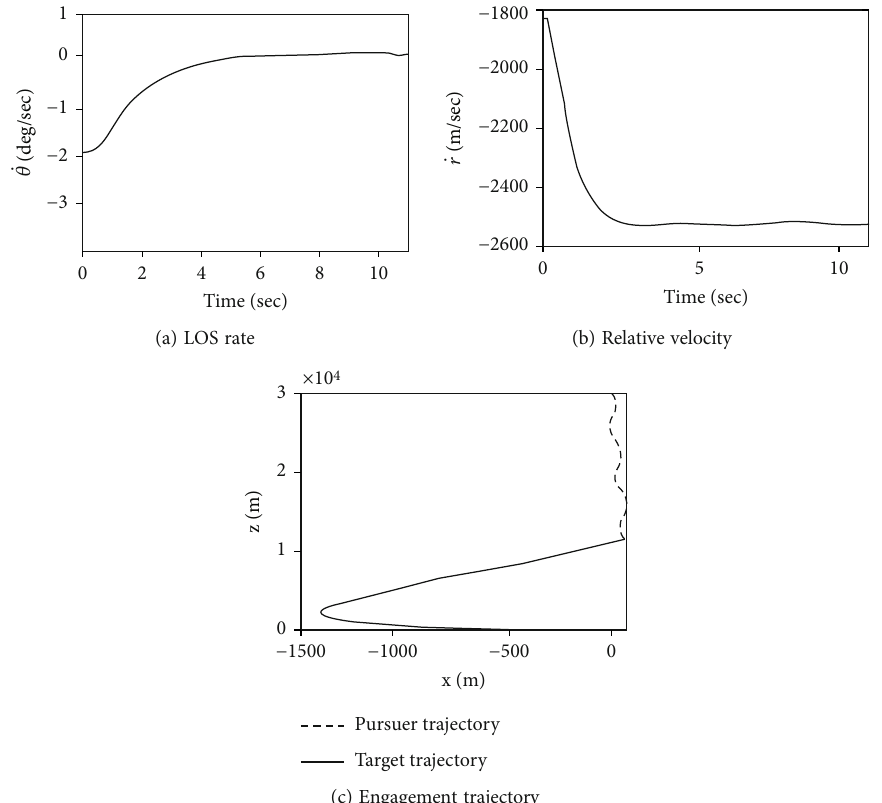
Figure 5: The engagement scenario against the sinusoidal-maneuvering